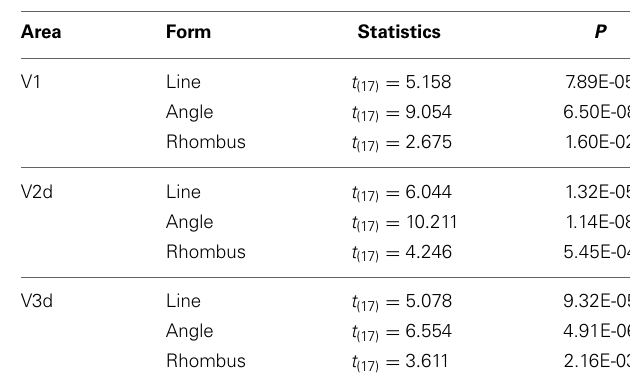
Table 1 | Results of one sample t -test comparisons of Blood-oxygen-level dependent signal intensities associated with areas and forms across nine